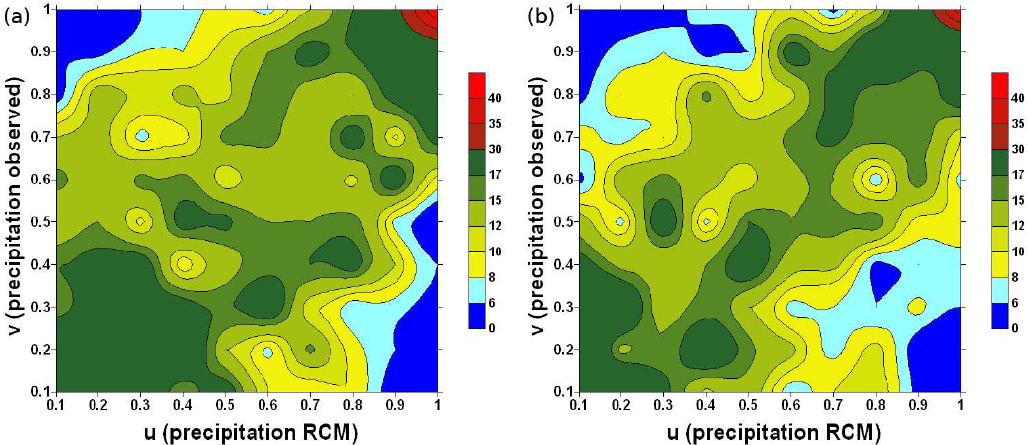
Fig. 11. Empirical Copula density for modelled ( u ) and observed precipitation ( v ) for Garmisch-Partenkirchen, using the weather type classification following the humidity of the troposphere: (a) D, and (b) W (D – dry, W –wet). between observations and the mean value of the random sam- ple, generated through the Copula approach is 0.36. Please note that the correlation coefficient between observations and RCM is calculated as 0.3 for the iid transformed data of Garmisch-Partenkirchen. This corroborates the usability of the Copula based bias correction of